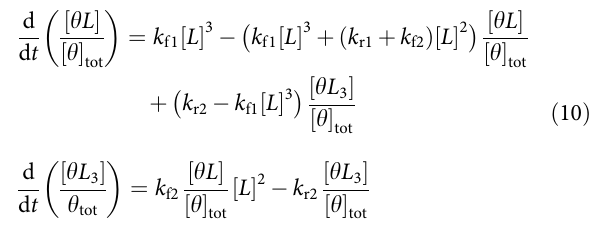
Figure 3 | Fluorescence spectroscopy of the SWCNT–fibrinogen interaction. ( a ) Relative fluorescent response of DPPE-PEG(5000)-SWCNT (1mgl (cid:2) 1 ) sensor to fibrinogen fragments (20 m gml (cid:2) 1 ). ( b ) Fluorescent emission spectra of DPPE-PEG(5000)-SWCNT with 0, 10 (cid:2) 4 , 2 (cid:4) 10 (cid:2) 4 , 4 (cid:4) 10 (cid:2) 4 , 8 (cid:4) 10 (cid:2) 4 , 1.2 (cid:4) 10 (cid:2) 3 , 1.6 (cid:4) 10 (cid:2) 3 , 2 (cid:4) 10 (cid:2) 3 , 4 (cid:4) 10 (cid:2) 3 , 8 (cid:4) 10 (cid:2) 3 , 1.2 (cid:4) 10 (cid:2) 2 , 1.6 (cid:4) 10 (cid:2) 2 , 2 (cid:4) 10 (cid:2) 2 , 4 (cid:4) 10 (cid:2) 2 , 8 (cid:4) 10 (cid:2) 2 and 0.2mgml (cid:2) 1 fibrinogen show substantial decrease in emission intensity with increasing protein concentration. Inset: absorption spectra of DPPE-PEG(5000)-SWCNTsuspension before (solid black curve) and after (dashed red curve) the addition of 0.02mgml (cid:2) 1 fibrinogen. ( c ) Excitation–emission profile of the DPPE-PEG(5000)- SWCNT solution before and ( d ) after the addition of 0.02mgml (cid:2) 1 fibrinogen. ( e ) The normalized fluorescent response of the various chiralities in the DPPE-PEG(5000)-SWCNTsuspension to the addition of different concentrations of fibrinogen (dots). The fit according to the model described in the text is plotted as solid lines. ( f ) The parameters of the model used for data fitting in d and their 95% confidence intervals. Dashed lines are guides to the eye. Top panel: the proportional parameter b used to fit the normalized fluorescent response model. Bottom panel: the parameters K d1 , and ( K d23 ) 1/2 used to fit the normalized fluorescent response model (blue squares and red circles, respectively). ( g ) Wavelength redshift of the (6,5) fluorescent emission peak of the DPPE-PEG(5000)-SWCNTsuspension to the addition of different concentrations of fibrinogen (dots). The fit according to the model described in the text is plotted as a solid line. ( h ) Sensor performance in a complex environment: relative fluorescent response of DPPE-PEG(5000)-SWCNT suspension following a two-step analyte addition. First, either albumin (columns 1–3), fibrinogen (columns 4–6), or an equal mixture of both (columns 7–9) was added to the solution to a final concentration of 20 m gml (cid:2) 1 and incubated for an hour. Then either PBS (columns 1, 4 and 7), albumin (columns 2, 5 and 8), or fibrinogen (columns 3, 6 and 9) was added to a final protein concentration of 40 m gml (cid:2) 1 . The fluorescent response was measured after an additional 1h incubation. ( i ) Relative fluorescent response of DPPE-PEG(5000)-SWCNT (5mgl (cid:2) 1 ) sensor to fibrinogen (0.05, 0.5 and 5mgml (cid:2) 1 ) in serum. Error bars represent the s.d. between three replicate